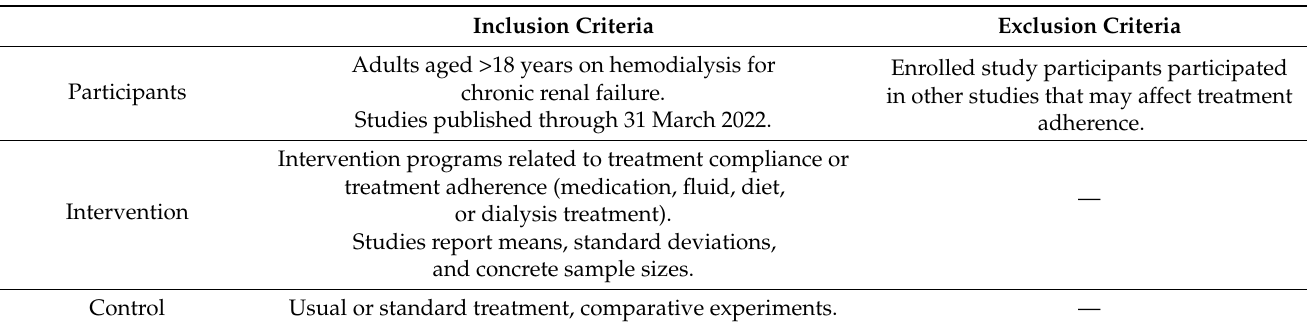
Table 1. Study eligibility